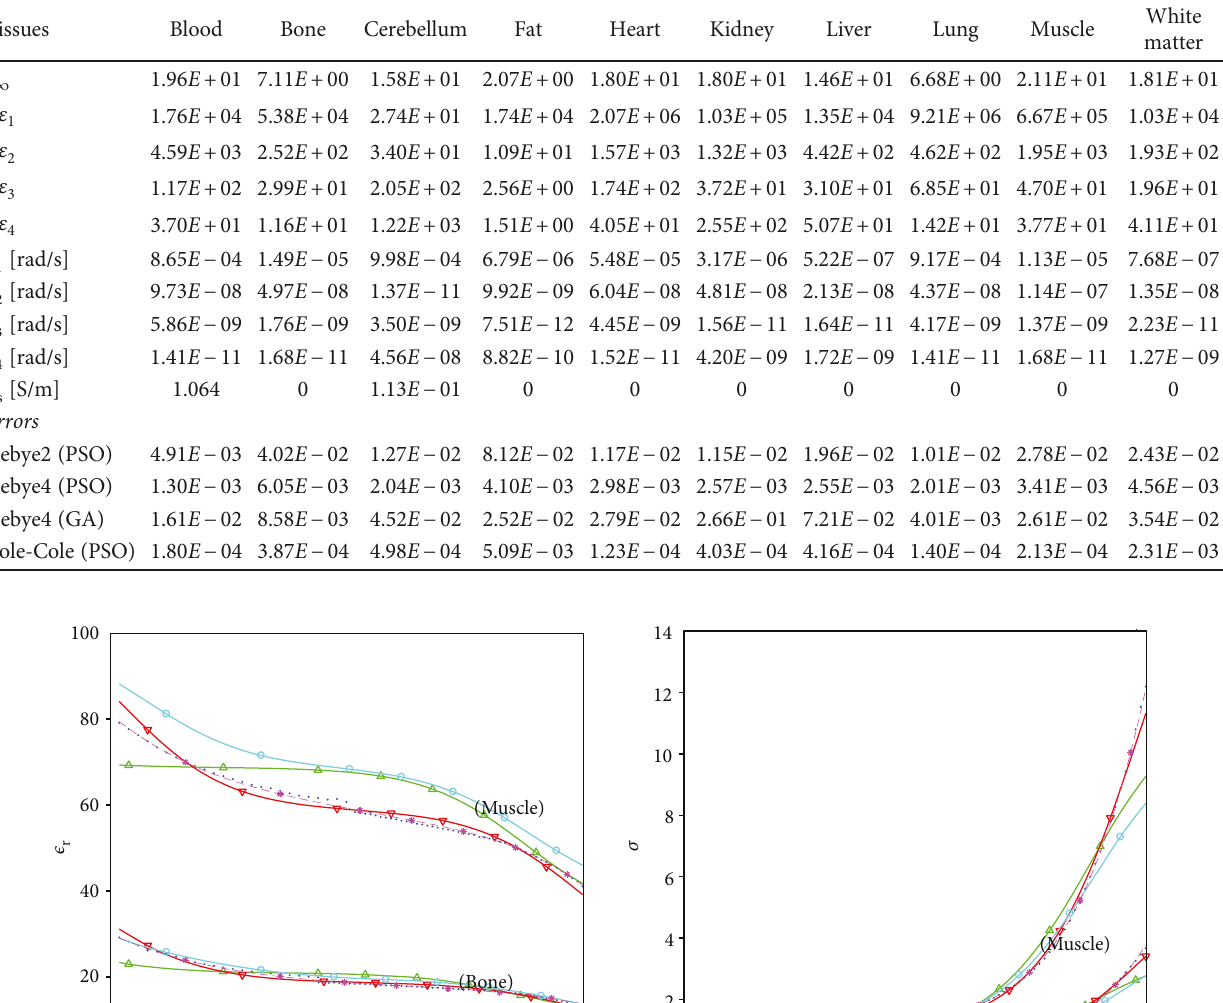
Table 1: Parameters of the four-pole Debye model of human tissues.